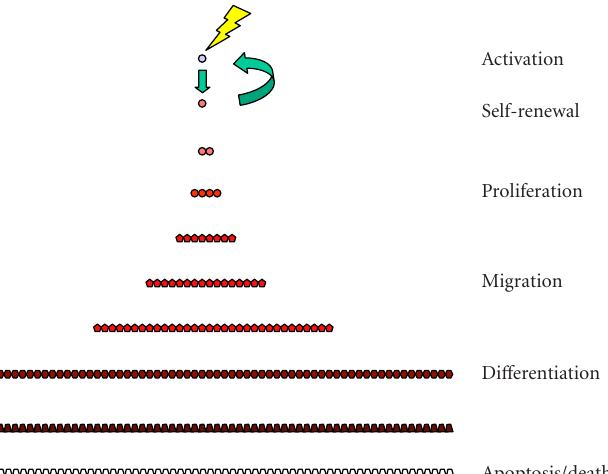
Figure 1. Six stages in the stem cell life cycle. In the simplest scenario, the life cycle of cells in a stem cell system involves at least six stages. This begins with the cycle of stem cell activation and cell division producing a progenitor cell and self-renewal of the stem cell, but is continuous with the process of proliferation of progenitors, migration, di ff erentiation, and eventual apoptosis or cell death.